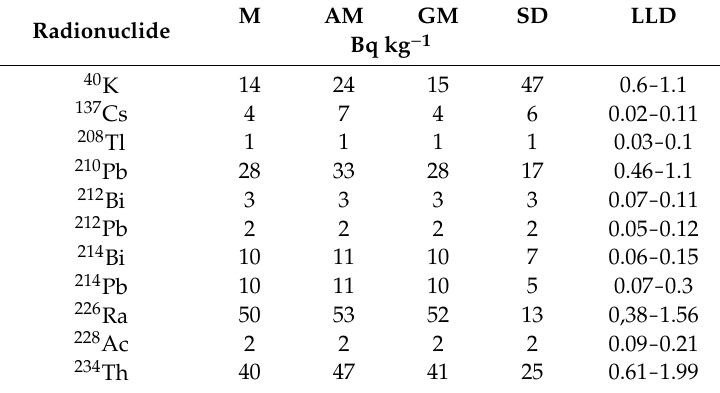
Table 1. The median (M), arithmetic mean (AM), geometric mean (GM), standard deviation (SD), and low limit of detection (LLD) of the specific radioisotope activity measured in all 61 samples.